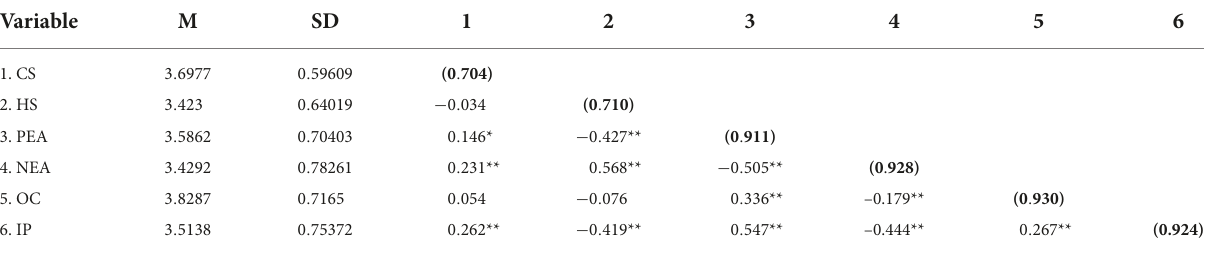
TABLE 2 Means, standard deviations, and correlations among variables.